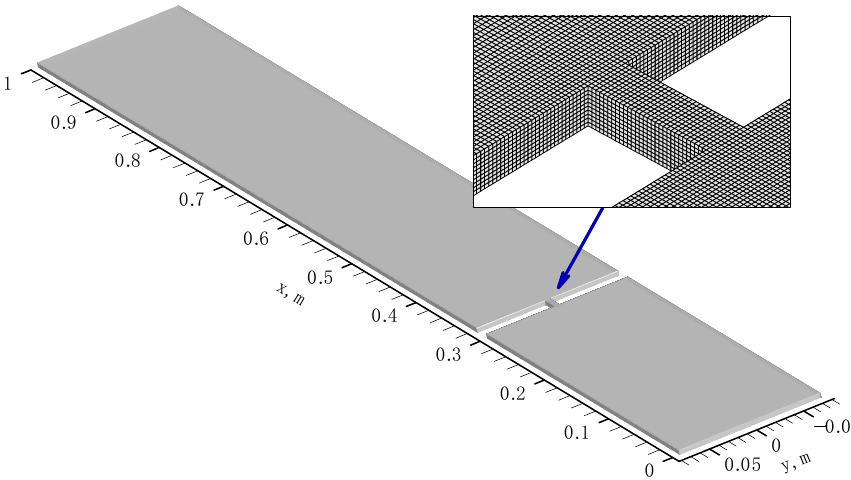
Figure 2. Computational domain and fragment of Cartesian mesh.